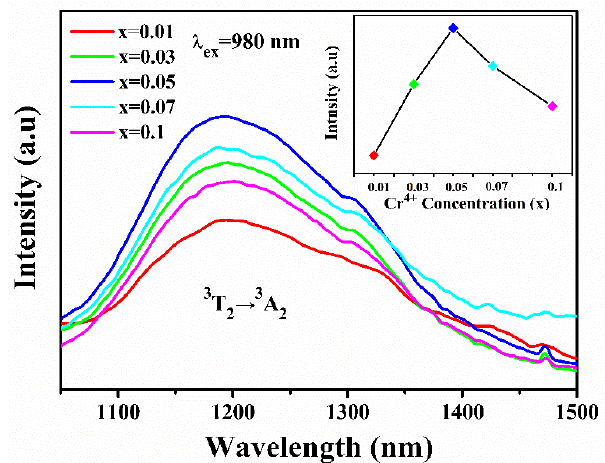
Figure 9. The persistent luminescence spectra of the Li 2 CaGe 1–x Cr x O 4 samples (x = 0.01, 0.03, 0.05, 0.07, and 0.1). Inset: Plot of the emission intensity vs. Cr-doping content.